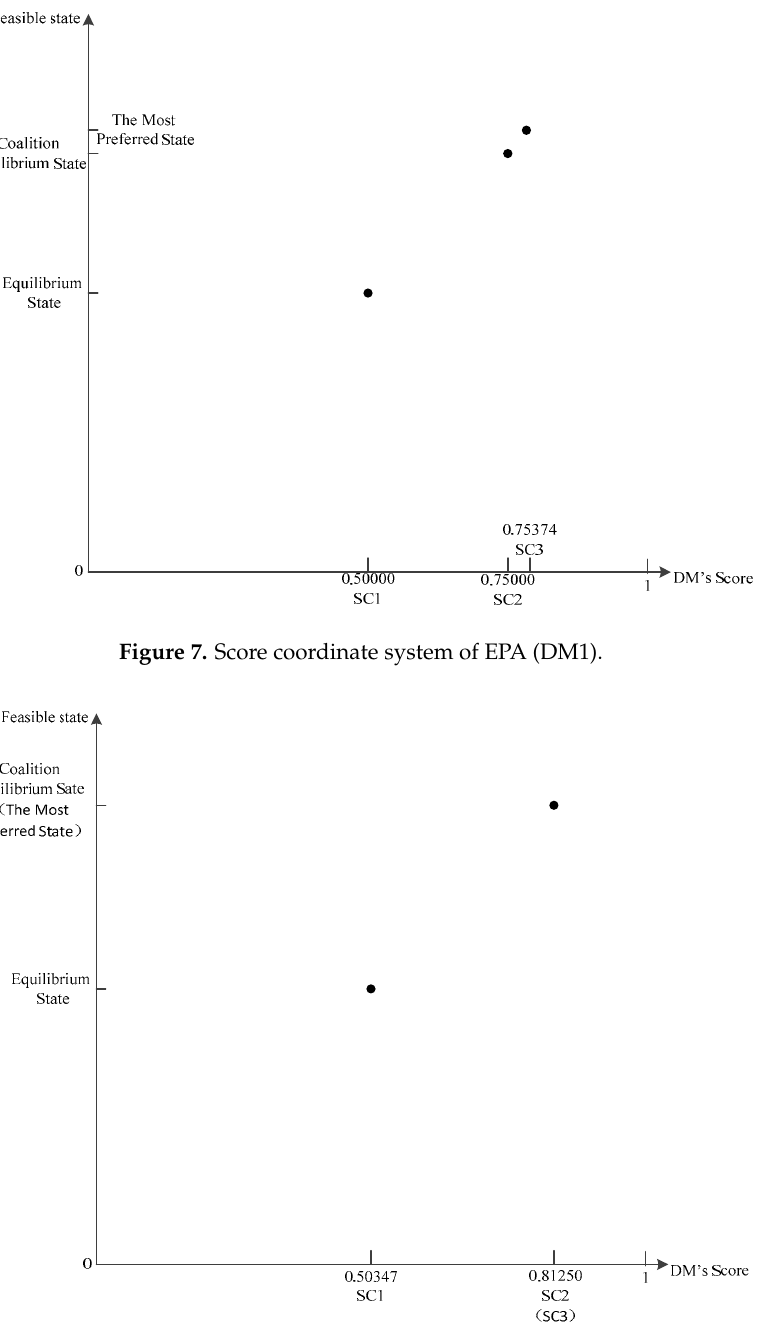
Figure 8. Score Coordinate System of GC (DM3).